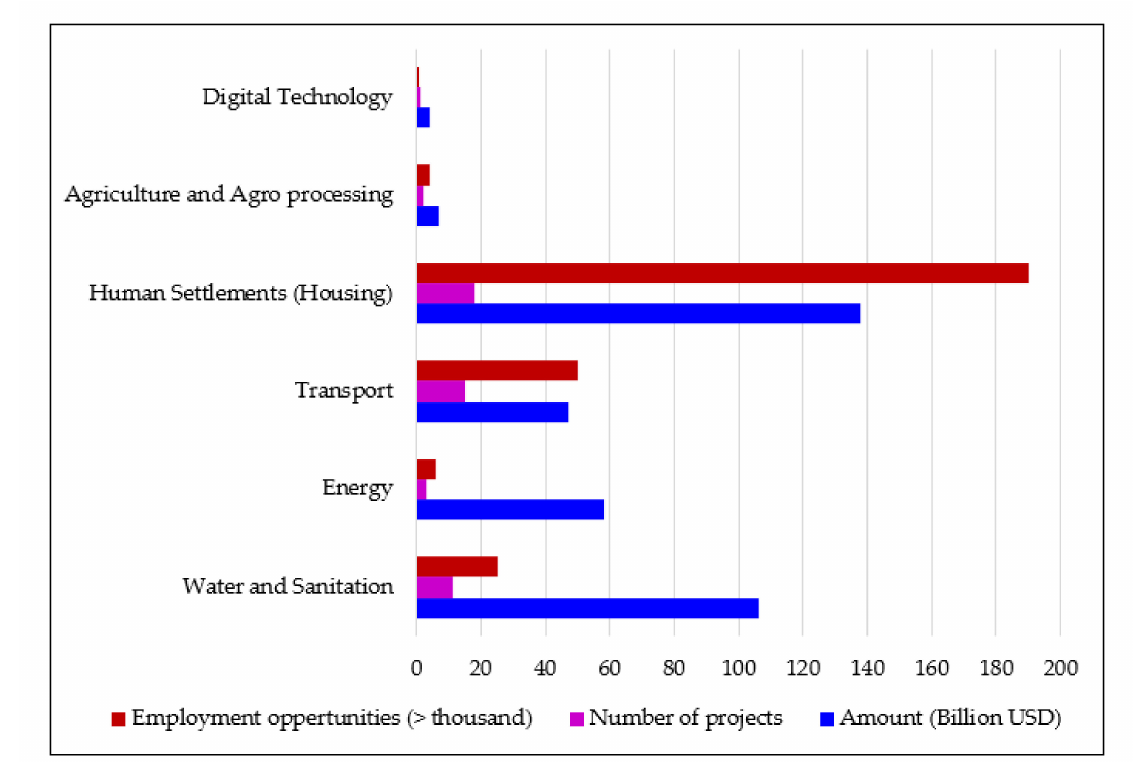
Figure 1. The scenario of future mega-projects to be undertaken per sector in South Africa under SIP